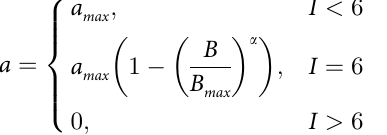
and r , or metabolized to CO 2 B L and r . Storage lipids can be recycled to the pool of CO2 , B CO2 , L